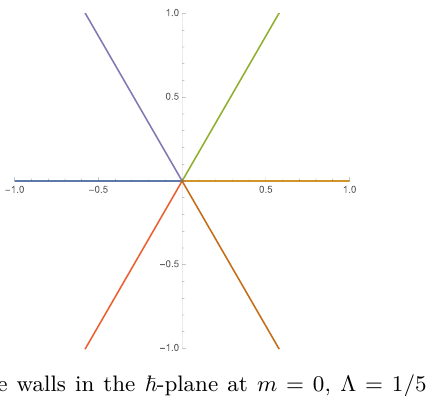
(a) The walls in the ~ -plane at m = 0 , Λ = 1 / 5 , u = 0 (strong coupling). Figure 1 . The strong coupling BPS spectrum consists of 3 hypermultiplets and their antiparticles, while the weak coupling BPS spectrum consists of 1 vectormultiplet and infinitely many hypermul- tiplets. There is a wall in the direction ϑ whenever there exists a BPS particle of charge γ with ϑ = arg( Z γ ) . (Generically each wall corresponds to a single particle, but in figure 1b each of the horizontal rays actually represents several BPS particles with the same phase: a vectormultiplet and two hypermultiplets. This accidental degeneracy would be broken for m 6 = 0 .) In figure 1b, the rays accumulate around ϑ = 0 , which is the phase corresponding to the vectormultiplet. This kind of accumulation happens generically in theories with higher-spin BPS particles.